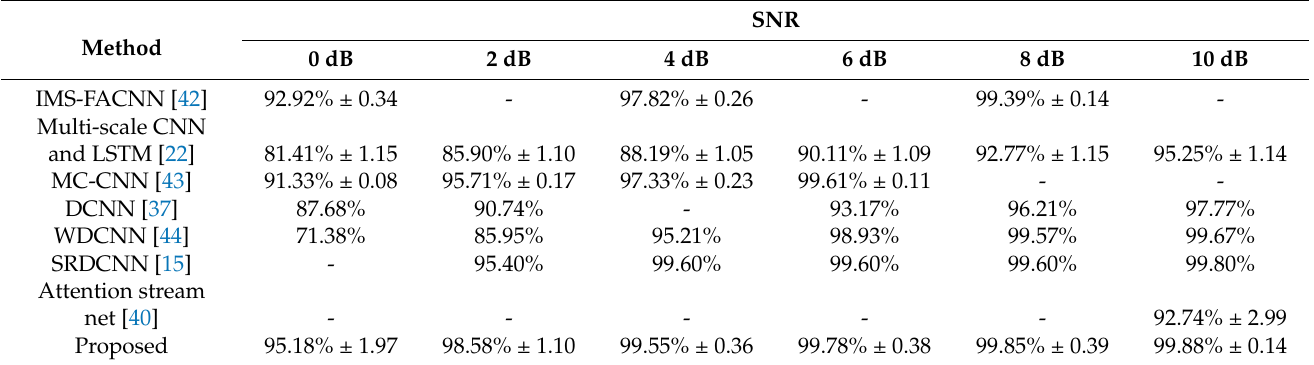
Table 5. Comparison of the accuracy of the proposed model with other methods in the presence of noise with different noise intensities.